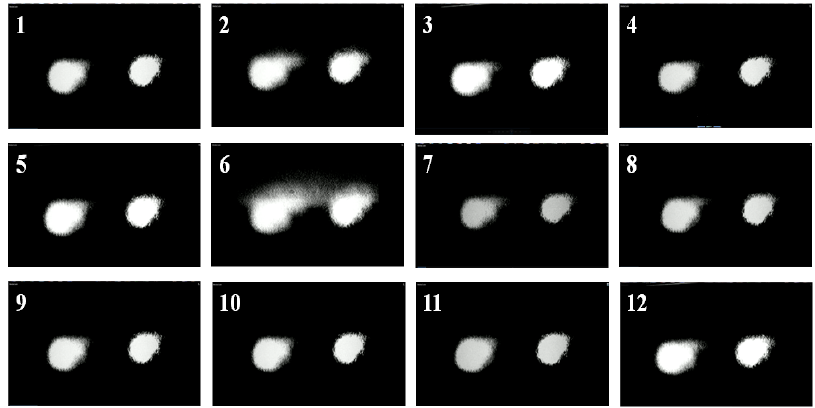
Figure 7. Snapshots of twelve different consecutive pulse pairs measured through a double L-scan geometry. Differences in size between pulses in the same picture are due the angle at which the CCD was placed during the measurements.